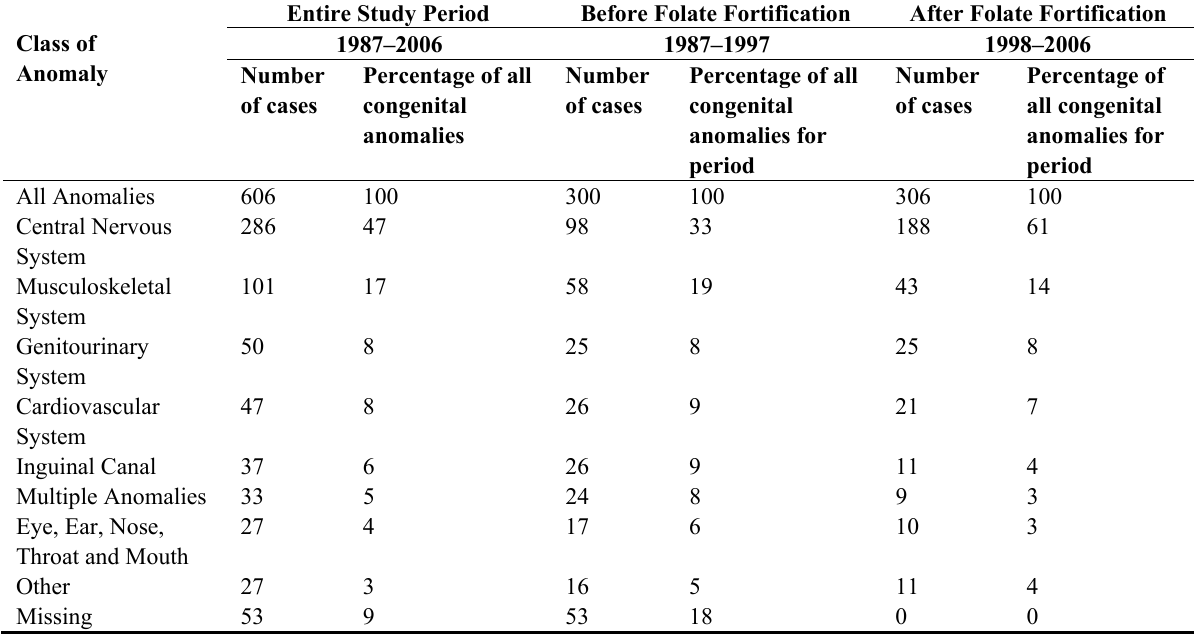
Table 2. Frequency of diagnoses of major congenital anomalies in Kings County, categorized by body system, over the entire study period (1987–2006), during the period prior to the fortification of food in Canada with folate (1987–1997), and for the period after folate fortification (1998–2006) *